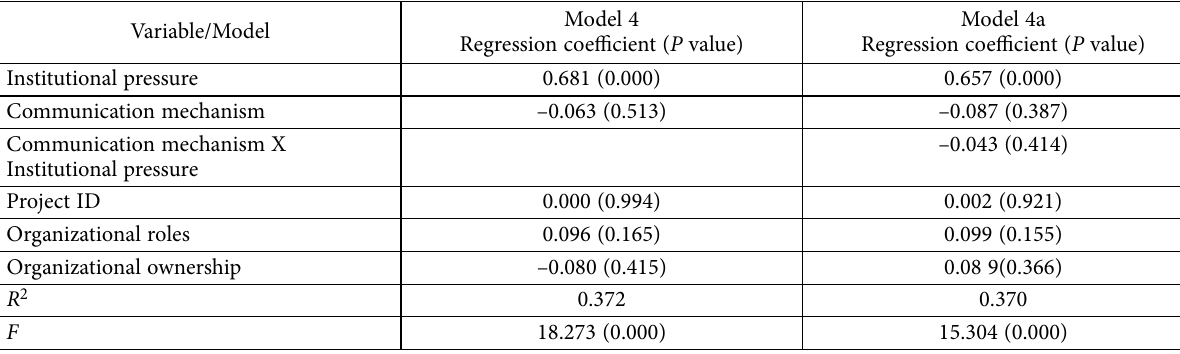
Table 8. Regression results for Model 4